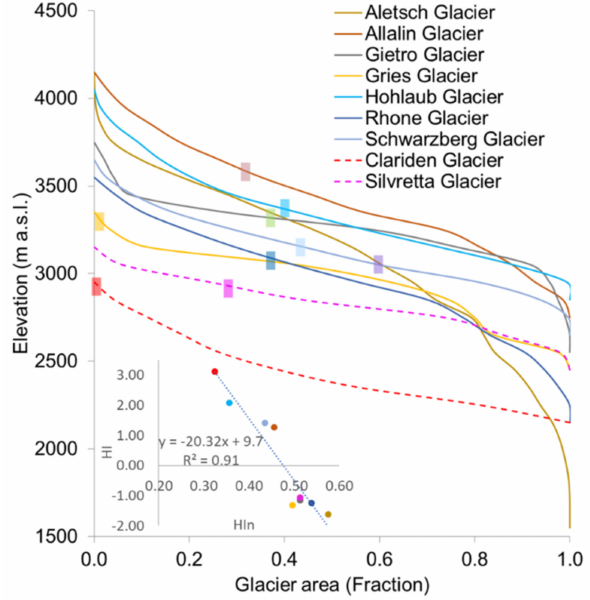
Figure 8. Comparable hypsometric profiles for selected glaciers. The colored boxes for each profile mark the ELA of the respective glacier. The dashed curves represent the two glaciers outside the catchment. The inset plot represents the relationship between HI and HIn for the studied glaciers.